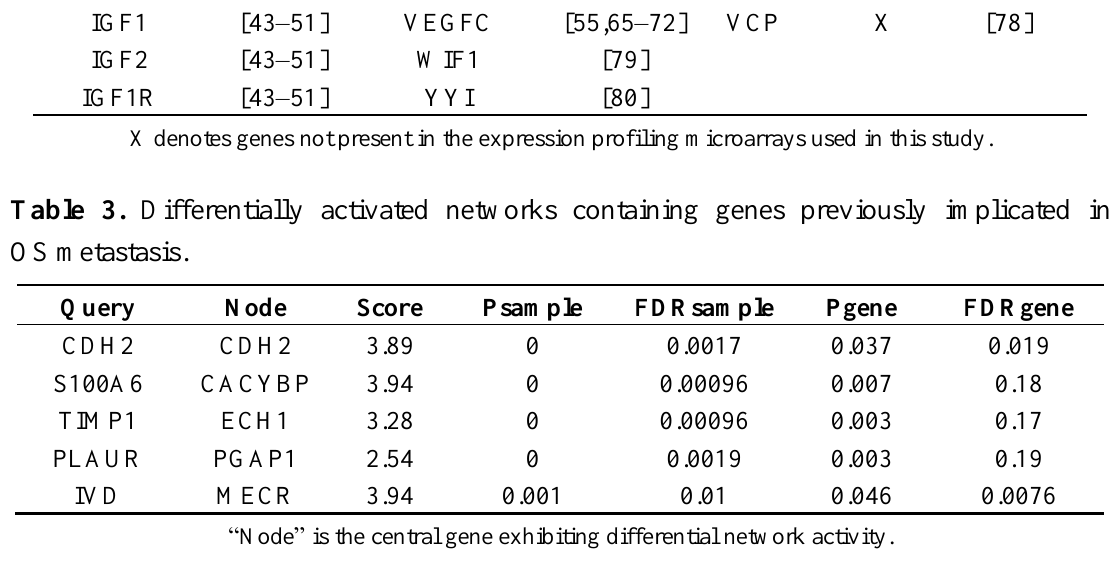
Table 4. Differentially organized networks containing genes previously implicated in OS